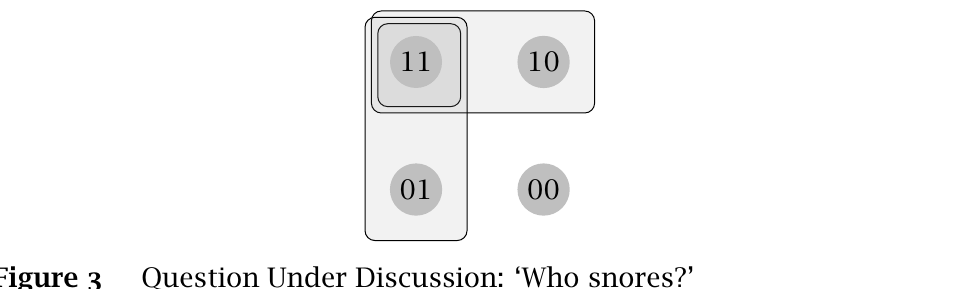
Figure 3 Question Under Discussion: ‘Who